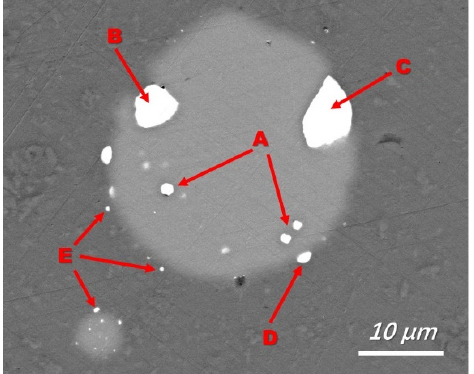
Figure 3. A typical Fe-concentrated phase in silicon droplets (backscattered electron image, No 1 slag with a refining time of 5 min). A: Fe-concentrated phase formed within the silicon drop; B: Fe- concentrated phase transferred to silicon-slag interface; C and D: Fe-concentrated phase wetted with slag phase and dissolved in slag; E: undissolved Fe-concentrated phase transferred into the slag.